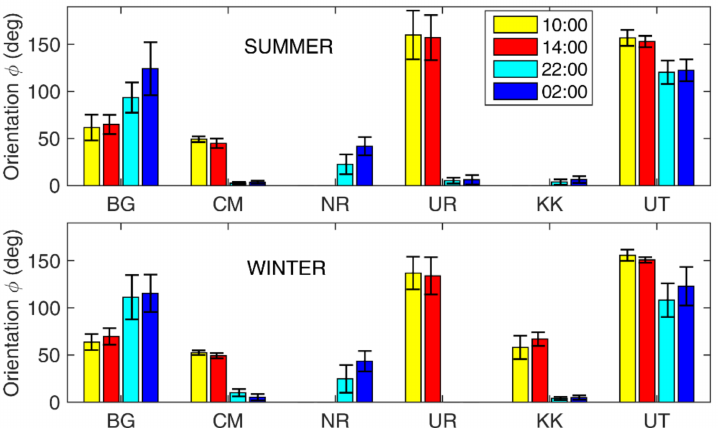
Figure 9. Intercity comparison of orientation angle ϕ (degree) during summer ( upper panel ) and winter ( bottom panel ); ϕ is averaged over the 14 years, considering the diurnal variation at 10:00, 14:00, 22:00, and 02:00. The black bar is the standard deviation across the